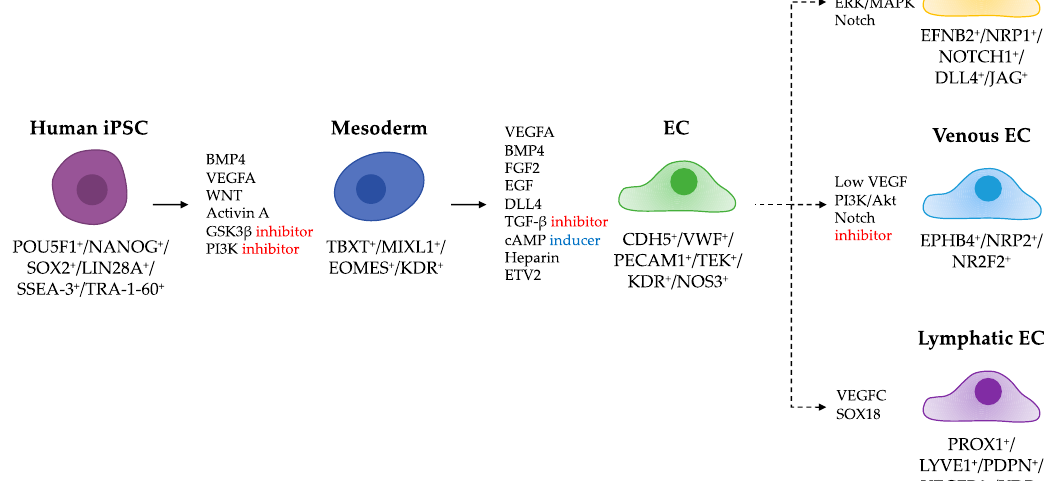
Figure 2. Proposed strategies to derive endothelial cells from hiPSCs via mesodermal lineages. Combinations of growth factors, cytokines, small molecules, transcription factors and phenotypic markers that define mesodermal cells or ECs are listed. Dashed lines indicate that hiPSC-derived ECs can be further differentiated into arterial, venous, and lymphatic EC subtypes.